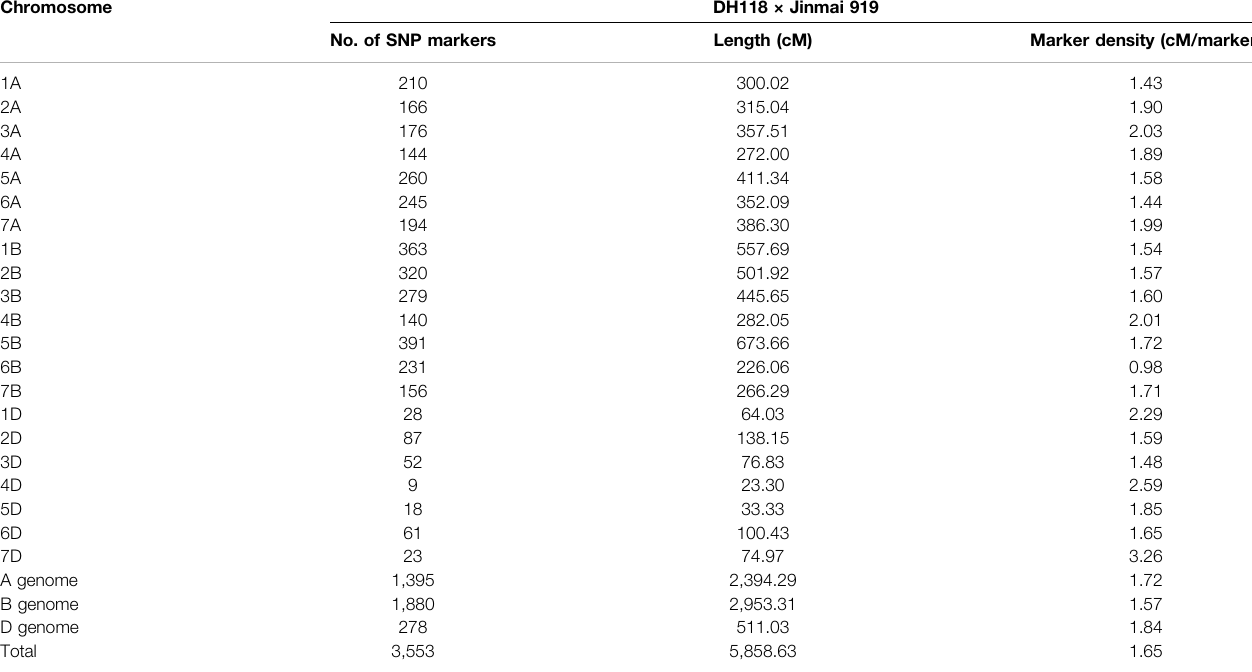
TABLE 2 | Summary of linkage group and marker statistics obtained from a 90K SNP chip analysis of the DH118×Jinmai 919 RIL population